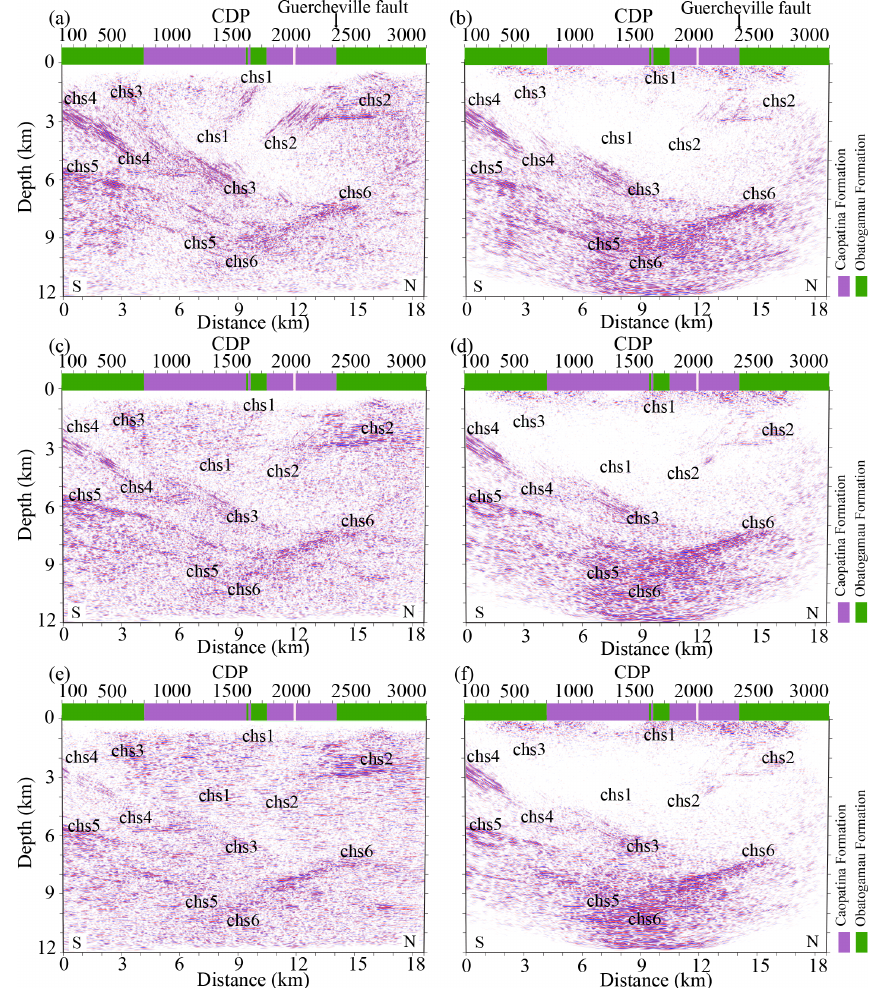
Figure 6. Migrated sections from the south survey considering an offset plane at a range of 0–9km. DMO-corrected migrated section and PSTM section shown in (a) and (b) , respectively, for an offset plane of 0–3km, in (c) and (d) , respectively, for an offset plane of 0–6km, and in (e) and (f) , respectively, for an offset plane of 0–9km. Prominent reflections are imaged in shallow and deep zones of the sections. For the interpretation of chs1, chs2, chs3, chs4, chs5, and chs6, see text. The rock units along the survey path are projected at the top of each section with no dip in the contacts implied. The surface location of the Guercheville fault is marked at the top of the